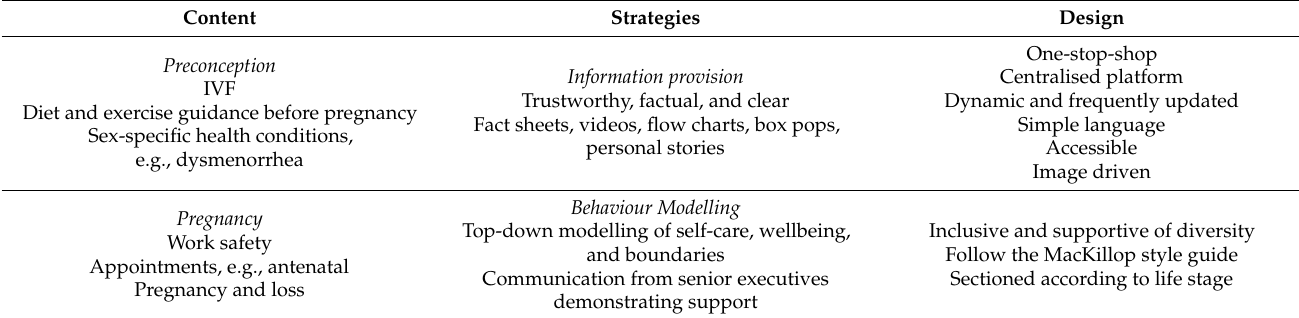
Table 6. Examples of content, strategies, and design for the HiPPP Workplace Portal at